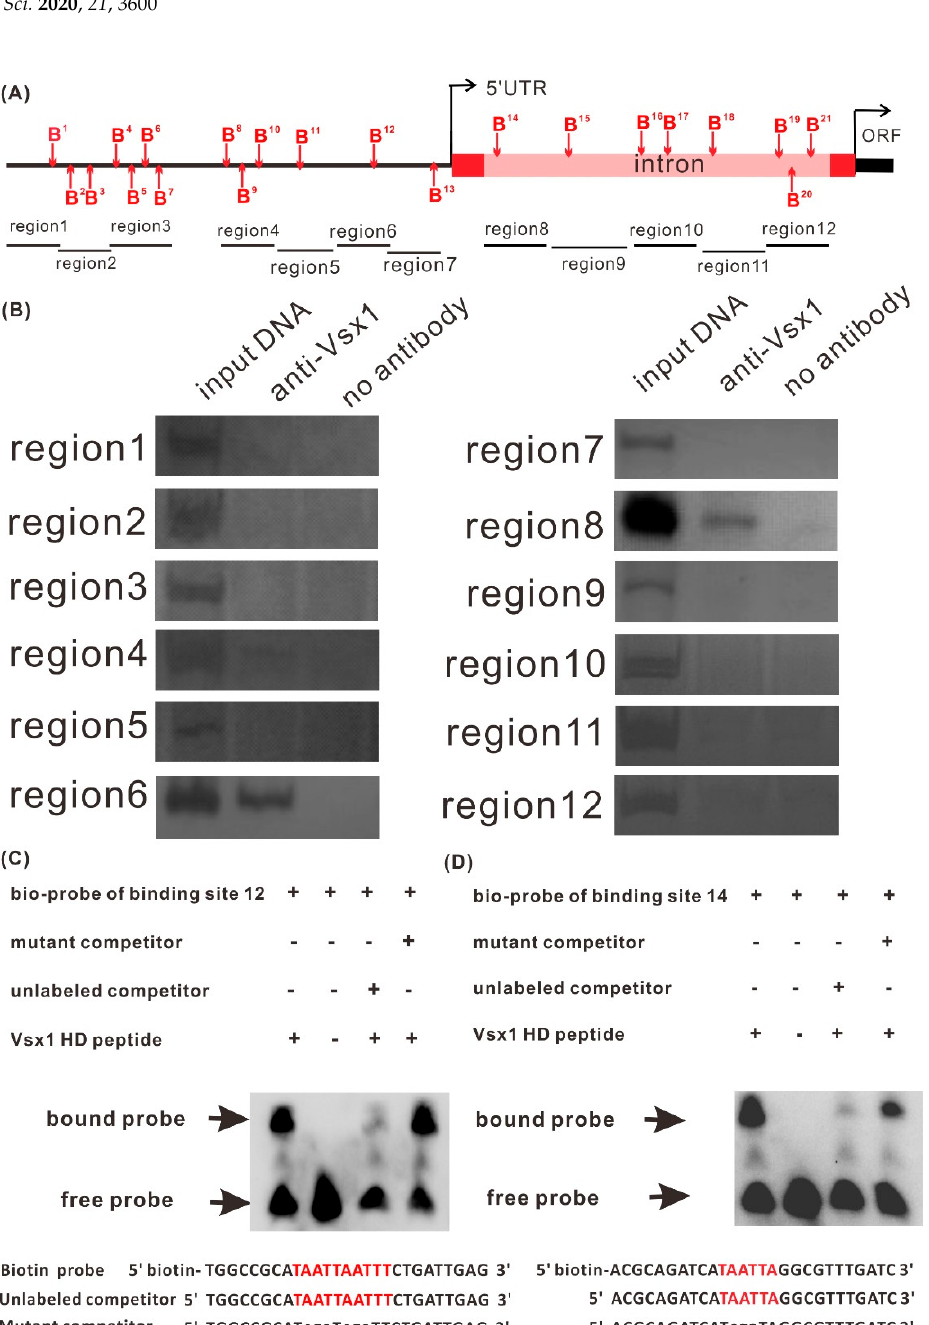
Figure 4. Vsx1 directly binds to tal1 proximal promoter at two specific sites. ( A ) The positions of potential Vsx1 binding sites B1–B21 at the proximal promoter of tal1 . The labels region 1–18 represent the examined regions in ChIP assay. ( B ) ChIP assay on extracts from wild type embryos. Input is the positive control with the sonicated original genomic DNA fragment. No antibody immunoprecipitation was used as negative controls for ChIP assay specificity. These results show that tal1 promoter region 6 and region 8 can recruit Vsx1. ( C–D ) Gel electrophoretogram of EMSA of potential binding sites 12 and 14 in region 6 and 8, respectively. The sequences of biotin tal1 probe and unlabeled wild-type and mutant competitors are shown at the bottom. Red and lower cases indicate the wild-type and mutant bases respectively, at binding sites 12 and 14.